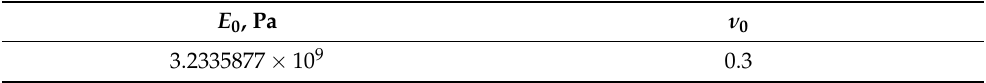
Table 6. Values of constants of the Williams–Landel–Ferry shift function.